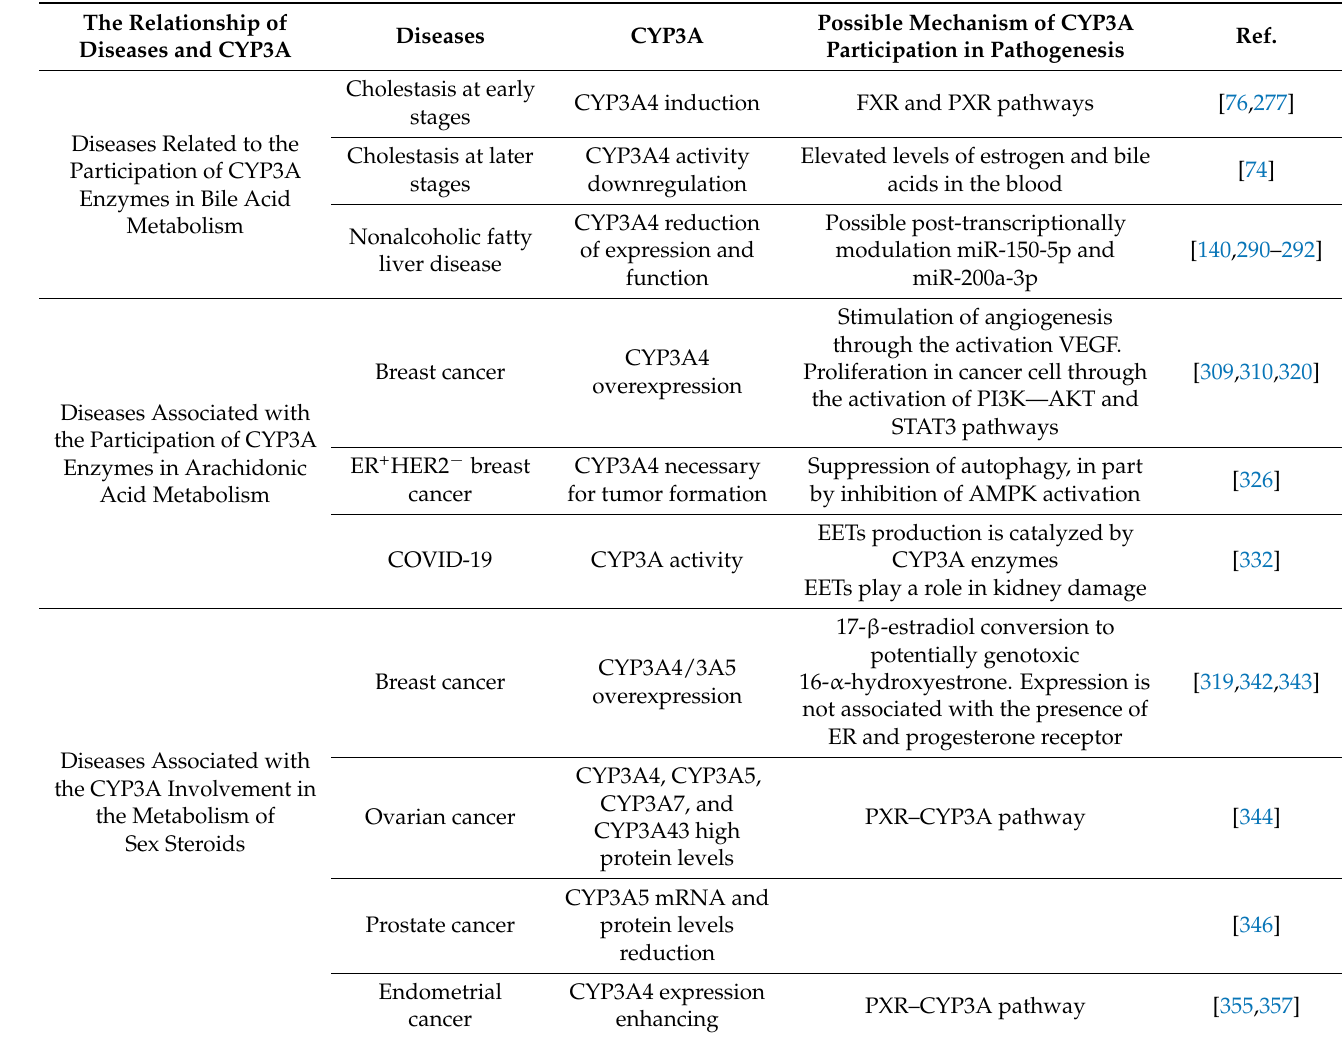
Table 3. CYP3A Involvement in Pathological